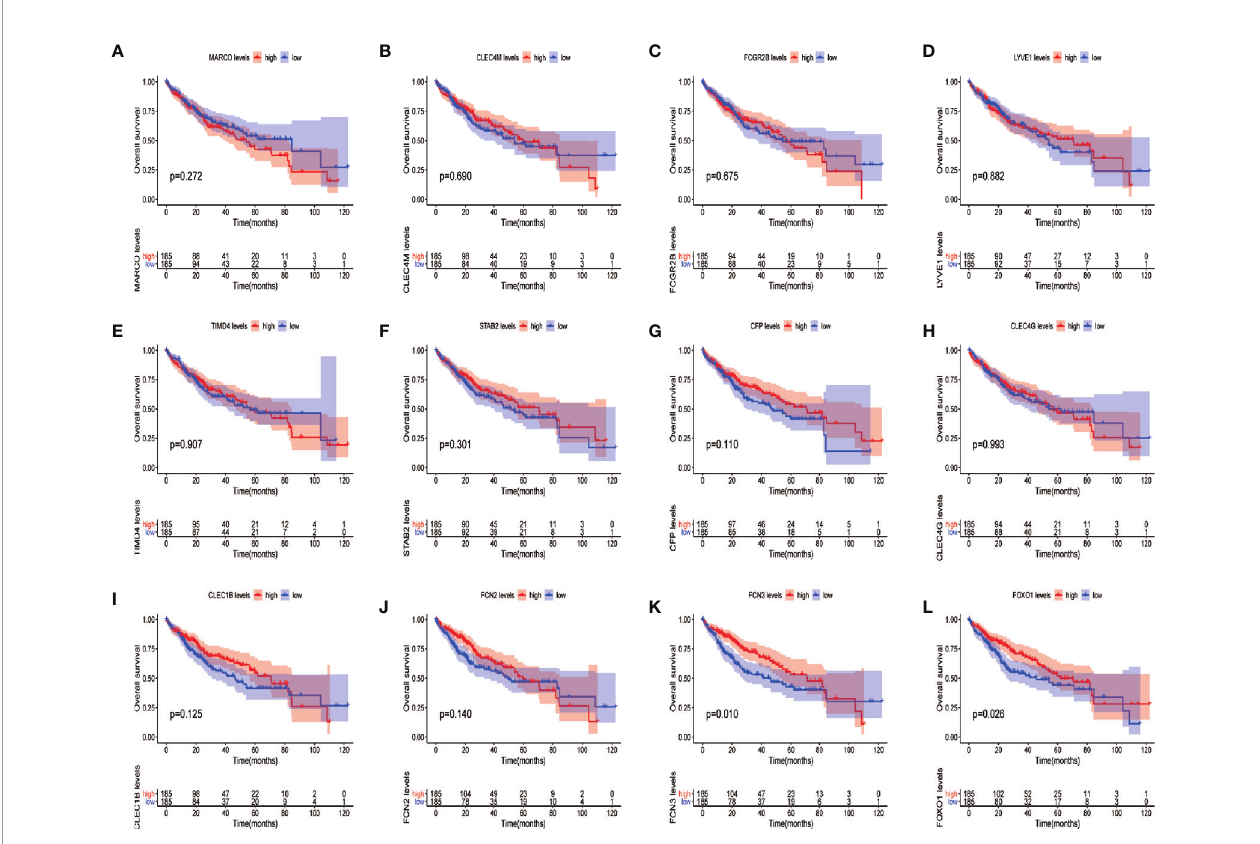
FIGURE 10 | Overall survival (OS) analyses of hub genes. (A) MARCO, (B) CLEC4M, (C) FCGR2B, (D) LYVE1, (E) TIMD4, (F) STAB2, (G) CFP, (H) CLEC4G, (I) CLEC1B, (J) FCN2, (K) FCN3 and (L) FOXO1. The red line represents samples with high gene expression, and the blue line represents samples with low gene